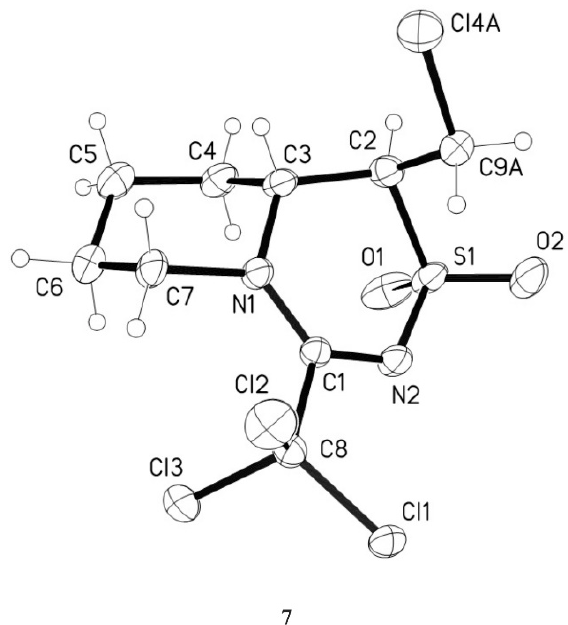
Figure 3. Molecular structure of 1 ‐ chloromethyl ‐ 4 ‐ trichloromethyl ‐ 1,6,7,8,9,9a ‐ hexahydropyrido[1,2 ‐ d ][1,2,4]thiadiazine ‐ 2,2 ‐ dioxide 7 : including thermal displacement ellipses with 50% probability. Molecules 2020 , 24 , x 7 of 21